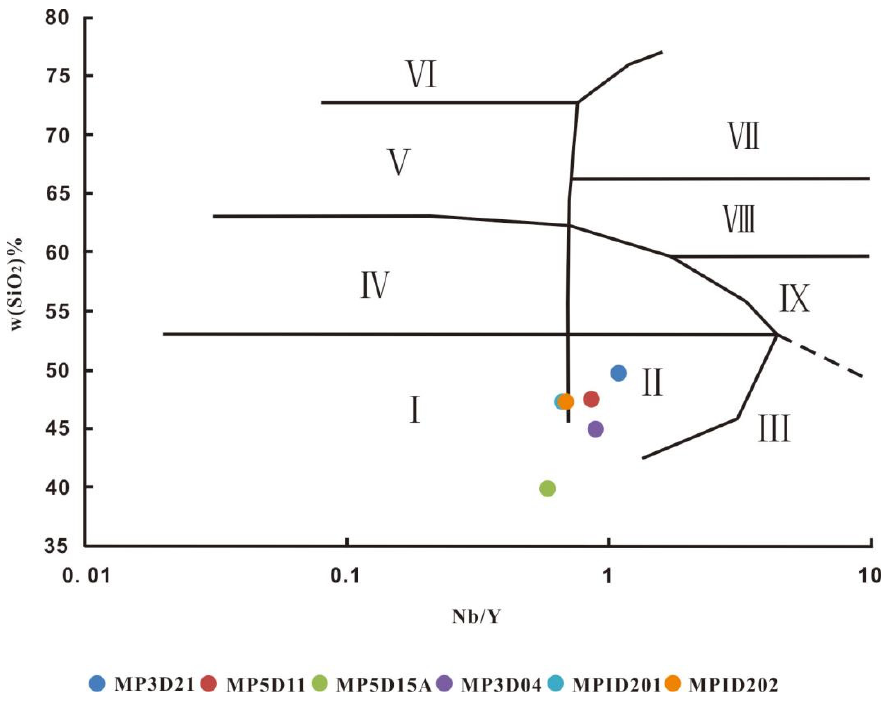
Figure 4. Nb/Y ‐ SiO 2 diagram of seamount basalts from the Western Pacific (after Winchester, J.A. et al., 1997 [27]). I: subalkaline basalt, II: alkaline basalt, III: basanite/nepheline, IV: andesite, V: rhyolite ‐ dacite/dacite, VI: rhyolite, VII: Sodium diorite alkali flow rock/alkali flow rock, VIII: trachyte, IX: phonolite.